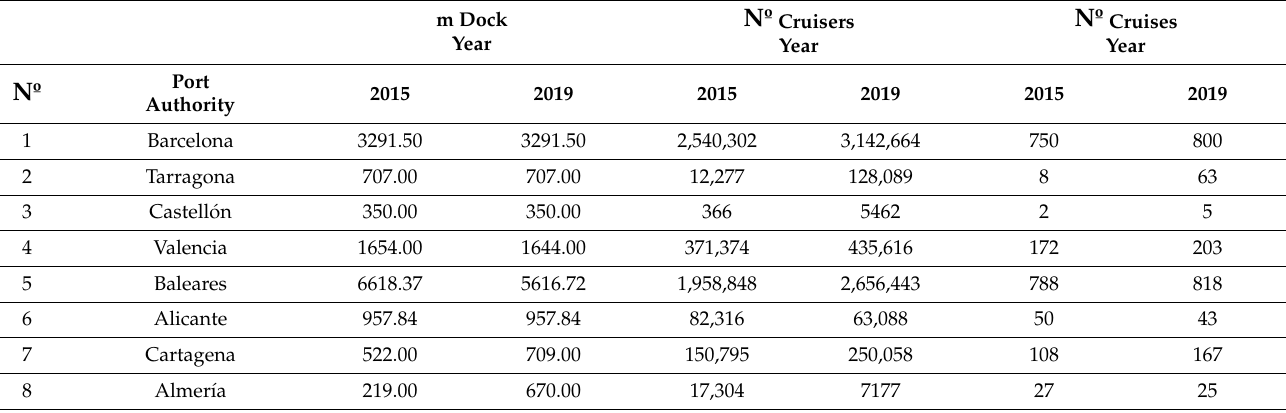
Table 2. Port data set to determine efficiency.